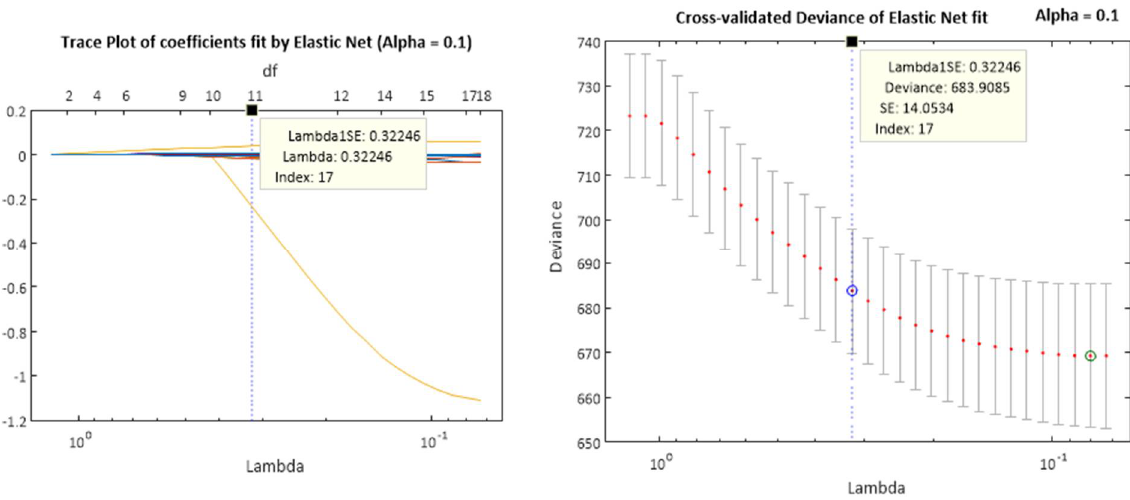
Figure A2. Elastic net trace and deviance plots for TD-All fit; lambda is selected as the value giving minimum deviance for a model size greater than or equal to 3 and less than or equal to 20.